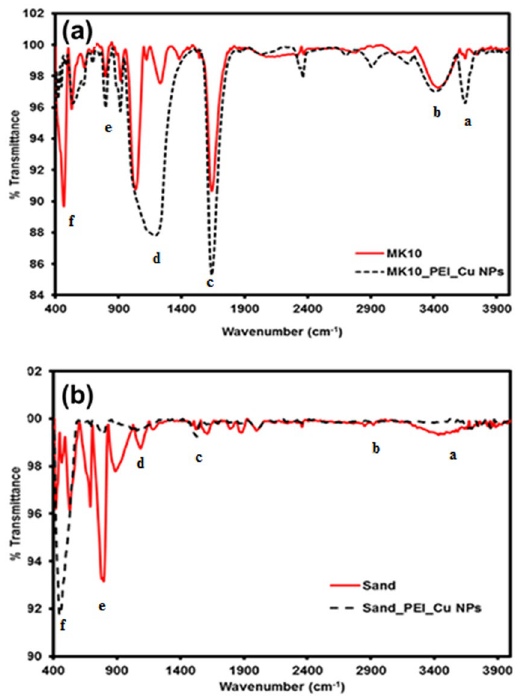
Figure 3. FT-IR spectra of unmodified and modified ( a ) MK10 and ( b )